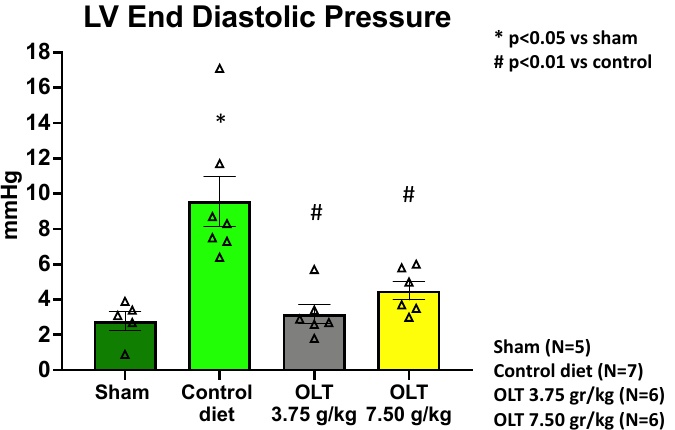
Figure 5. LV catheterization and assessment of LVEDP at 10.5 weeks after the coronary artery ligation surgery show that both of the OLT-treated mouse groups (3.75 g/kg and 7.50 g/kg) had a significant decrease in LVEDP, indicating that the treatment with OLT1177 led to a preserved diastolic function. Each triangle corresponds to the value measured in each mouse. The values are expressed as the mean ± SEM.